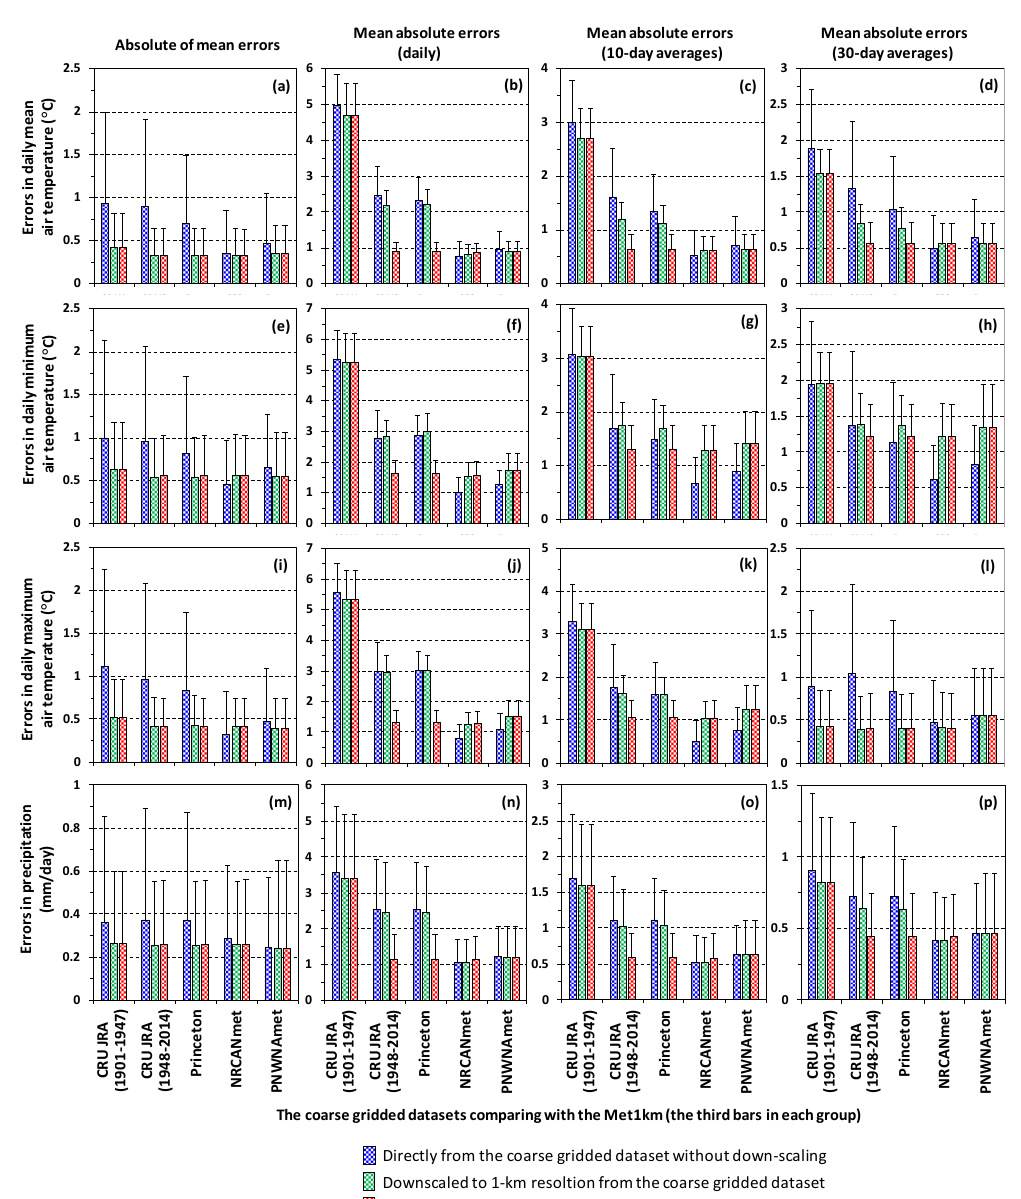
Figure 12. Comparisons of the errors of the source datasets, the spatially downscaled source datasets and Met1km (the three bars in each group respectively) ( a – p ). The errors were calculated by comparing with the homogenized daily climate station data [43]. The four rows are for di ff erent climate variables, and the four columns are for the errors in long-term averages and the mean absolute errors for daily values, 10-day averages and 30-day averages. The large bars and the error bars are the averages and the standard deviations of the errors of all the climate stations. The errors of Met1km (the red hatched bars) are di ff erent in each panel due to di ff erences in periods of the datasets and spatial domains of the NRCANmet and PNWNAmet